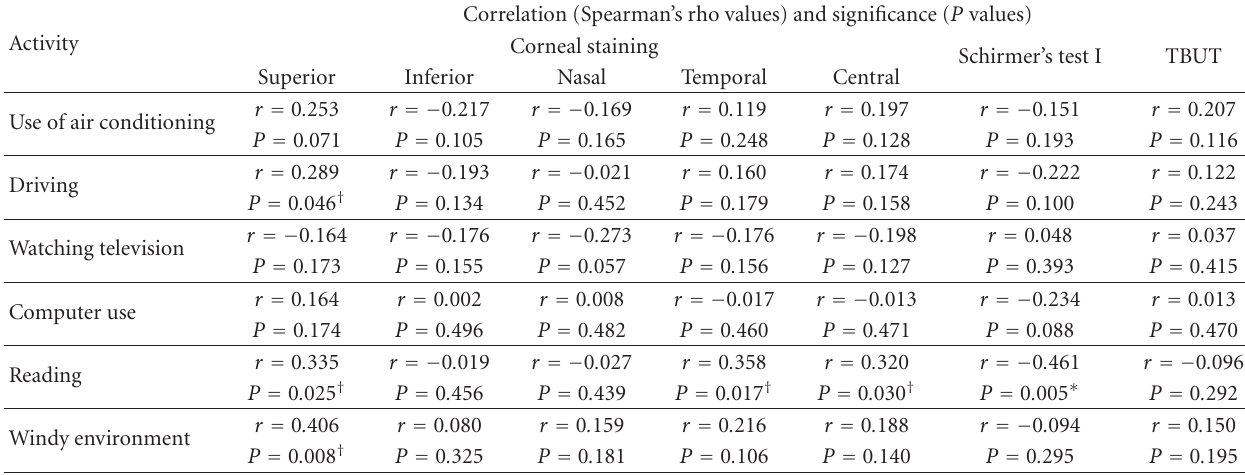
Table 3: And their relations with DED clinical signs represented with the Spearman’s rho ( r ) and P values. Correlation (Spearman’s rho values) and significance ( P values) Activity Corneal